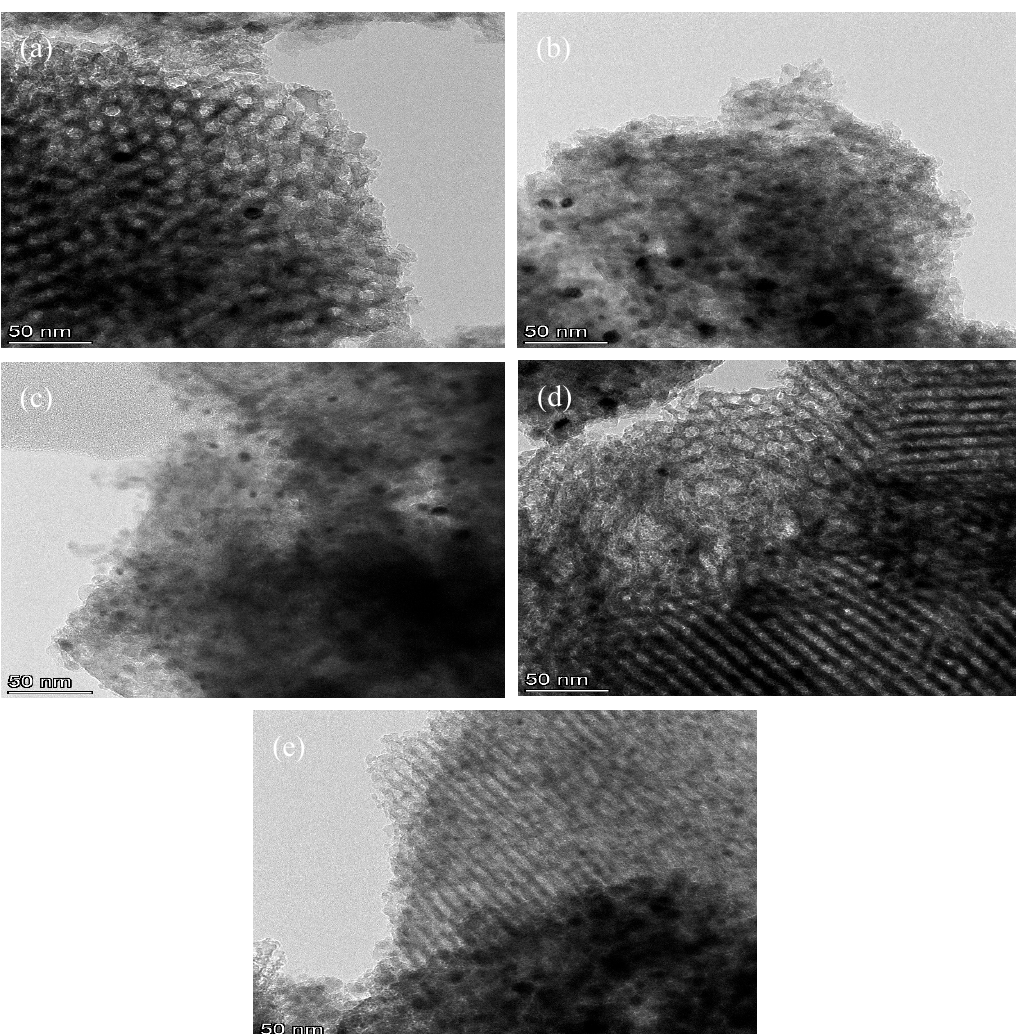
Figure6. TEMimagesofreducedcatalysts. 4%Ni / M100-MA( a ), 6%Ni / M100-MA( b ), 8%Ni / M100-MA Figure 6. TEM images of reduced catalysts. 4 % Ni/M100-MA ( a ), 6 % Ni/M100-MA ( b ), 8 % Ni/M100- ( c ), 10 % Ni / M100-MA ( d ), and 12 % Ni / M100-MA ( e MA ( c ), 10 % Ni/M100-MA ( d ), and 12 % Ni/M100-MA ( e ).